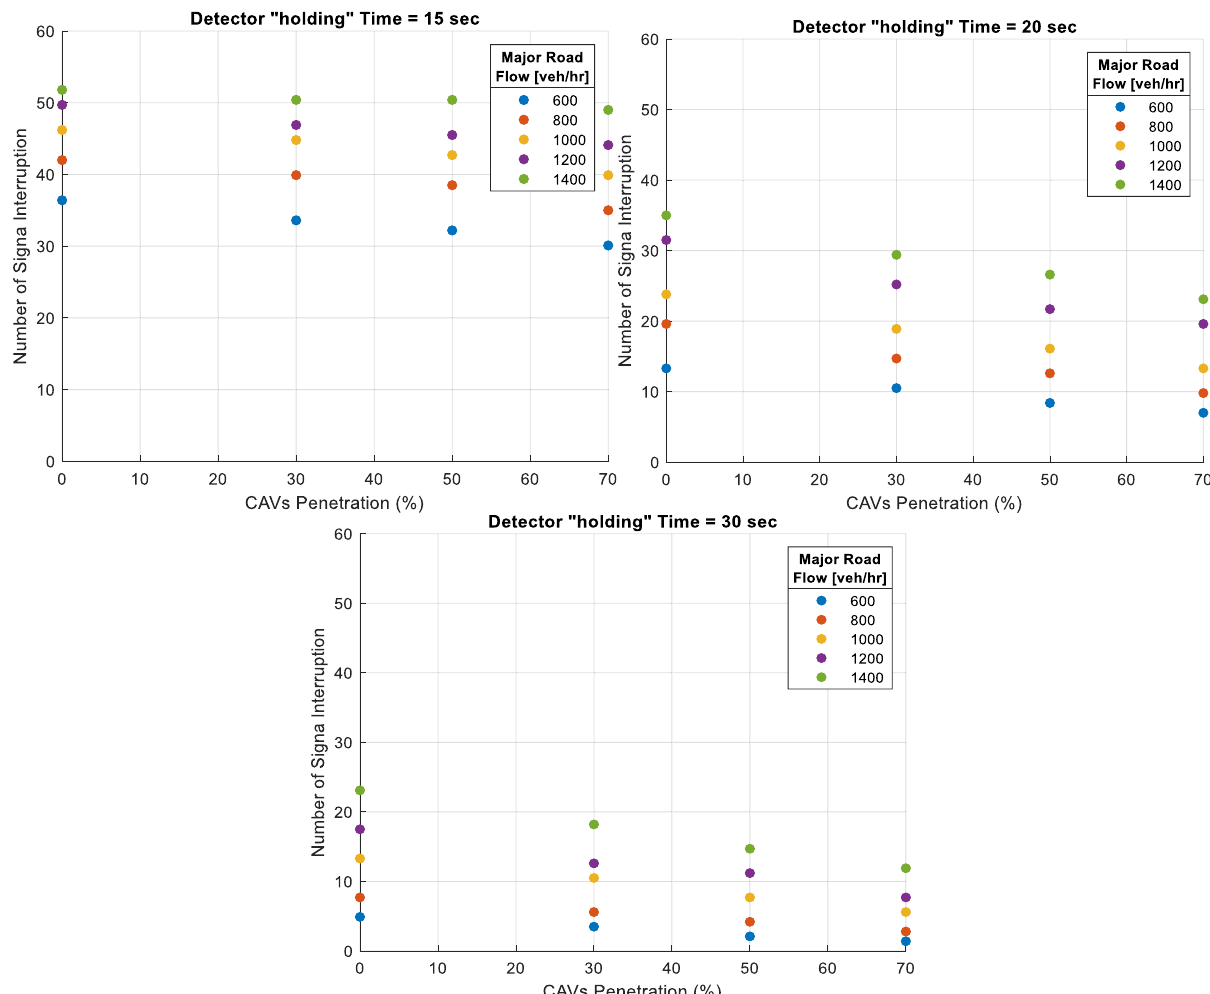
Figure 13: Signal interruptions on the mainline at 250 veh/h on the minor